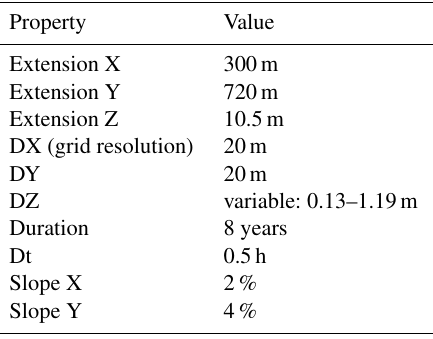
Table 2. Model set-up